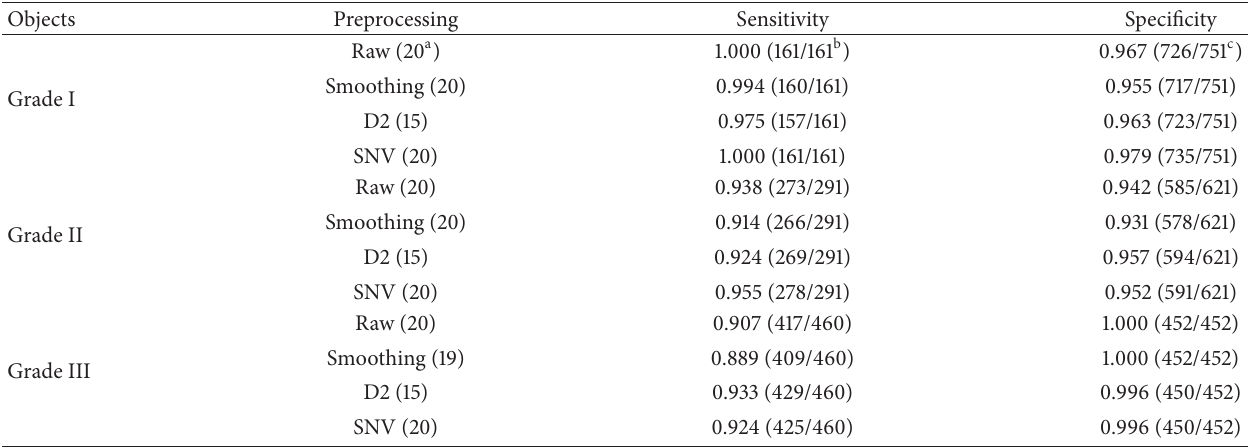
Table 2: Classification results of three grades of Longjing with different preprocessing